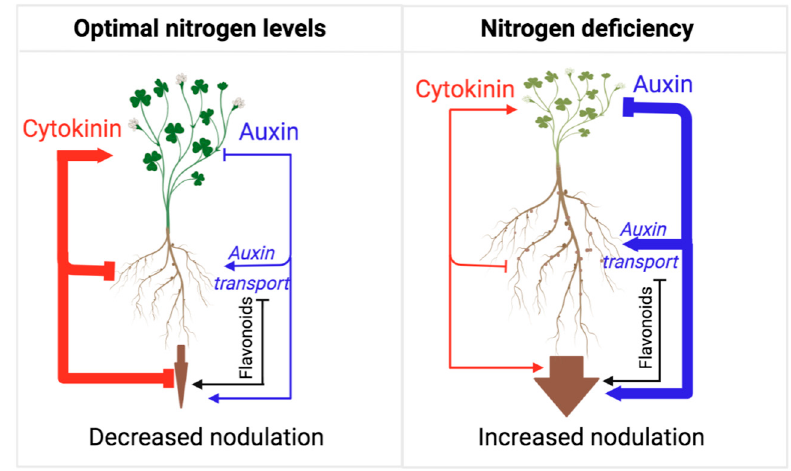
Figure 4. Model representing the actions of auxin and cytokinin on root nodulation from the perspective of adaptive control of the shoot/root growth ratio. As long as the plant perceives nitrogen deficiency in the soil, nodulation frequency is high, mirroring a low shoot/root growth ratio and the allocation of resources towards root growth and nodulation. Under nitrogen-deficient conditions, auxin action is high, which represses cytokinin action and shoot growth in favor of root growth and nodulation. Under nitrogen-sufficient conditions, auxin action is reduced, and cytokinin action is released to promote shoot growth and inhibit root growth and nodulation. This mechanism ensures optimal resource allocation for shoot growth and reproduction under optimal nitrogen conditions. Flavonoids play an essential role in this process, as they promote several stages in this symbiotic interaction and thus help with the auxin-dependent promotion of nitrogen